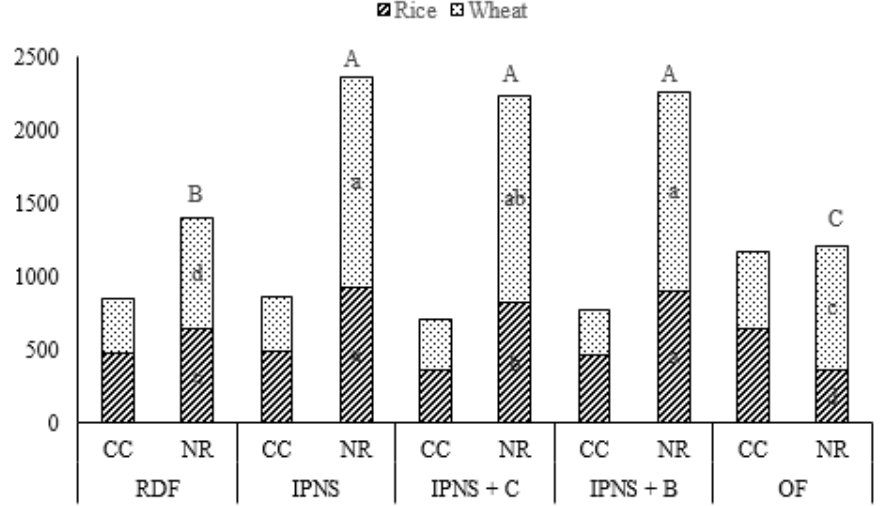
Figure 6. Economics (US$ha − 1 ) of different nutrient management practices in rice and wheat under long-term RWS. CC and NR denote the cost of cultivation and the net returns, respectively. Values followed by different lower case letter(s) within rice or wheat for the net returns are statistically significant ( p < 0.05). Values followed by different capital letter(s) within RWS for net return are statistically significant ( p < 0.05).